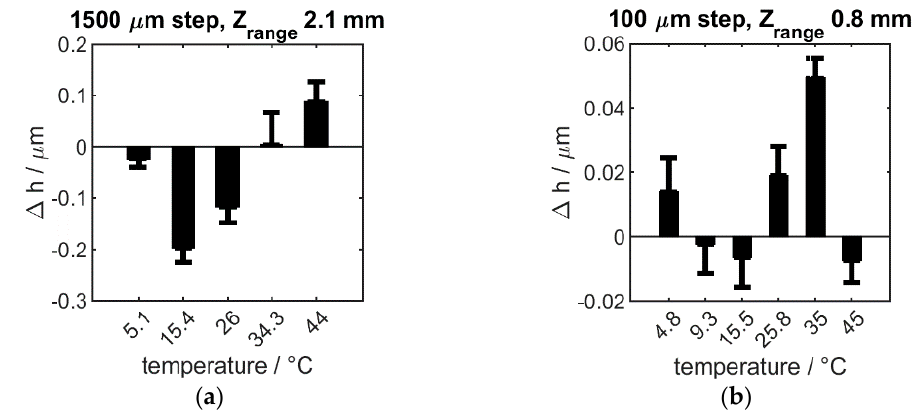
Figure 8. The influence of temperature on measurement quality: the difference ( Δ h) of the same step-height, as measured at room temperature and at the temperature shown on the x axis is plotted. This is shown for a large ( a ) and a small step size ( b ). Standard deviation is shown by the single-sided positive error bars.